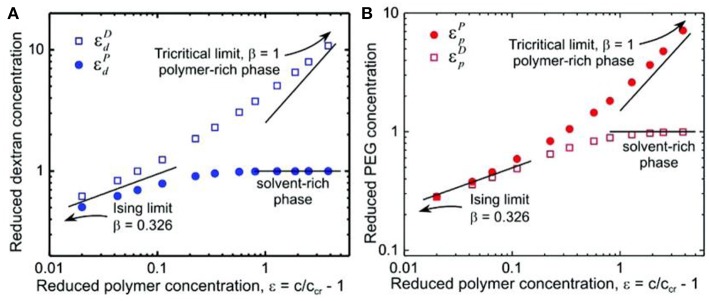
Logarithmic scaling plots of phase-coexistence curves for (A) dextran and (B) PEG. The solid lines are guides to the eye with scaling exponents of 0.326 for the Ising model limit and 1 for the tricritical limit and a constant of 1 for the solvent-rich phase. Reprinted with permission from Liu et al. (2012). Copyright (2012) American Chemical Society.